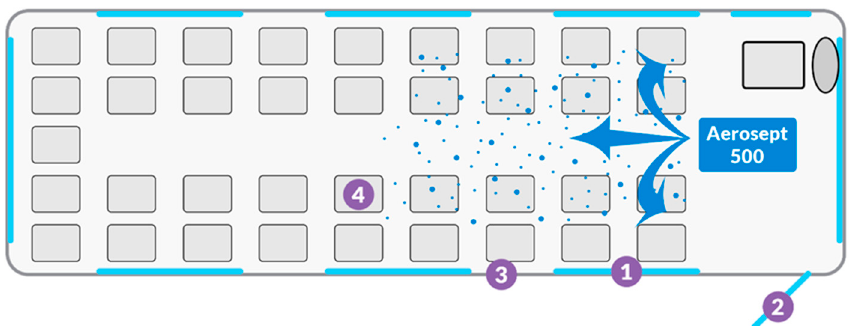
Figure 1. Sample picture of vehicle disinfection and sampling from individual surfaces (1—windows, 2—doors, 3—walls, 4—seatbacks).